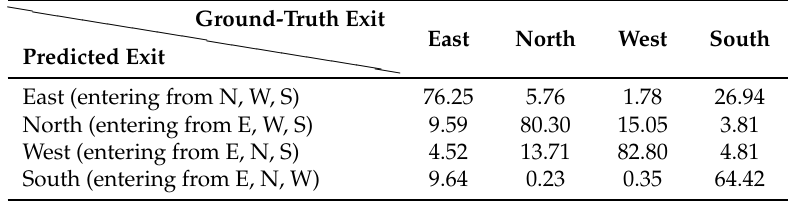
Table 1. Confusion matrix for predicted vs. ground-truth exits, using particle-filtering method for intention estimation.